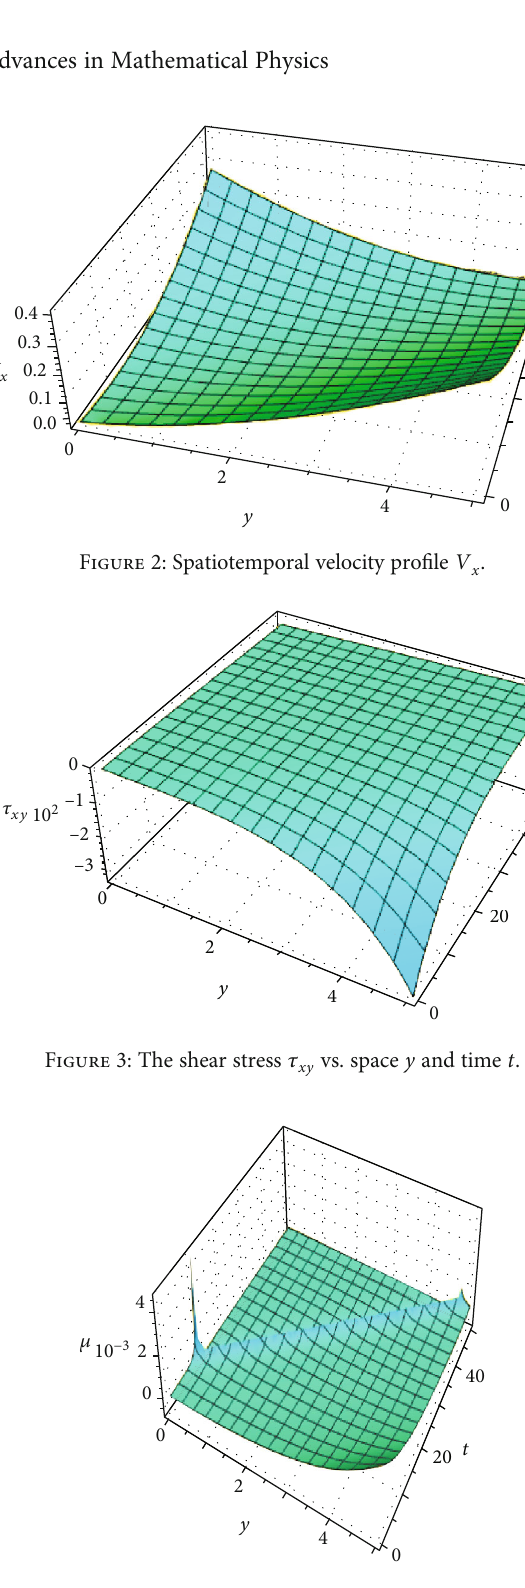
Figure 4: The viscosity coe ffi cient μ vs. space y and time t .